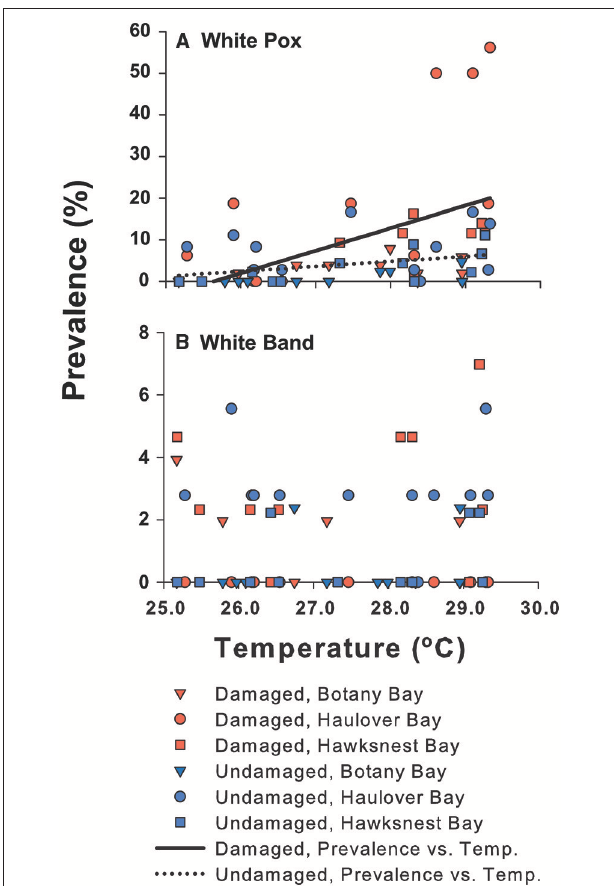
FIGURE 5 | The prevalence of (A) white pox and (B) white band disease on Acropora palmata vs. temperature among damage states and sites. The relationship of white pox disease with temperature is shown as regression lines for damaged and undamaged colonies. White band disease was not associated with